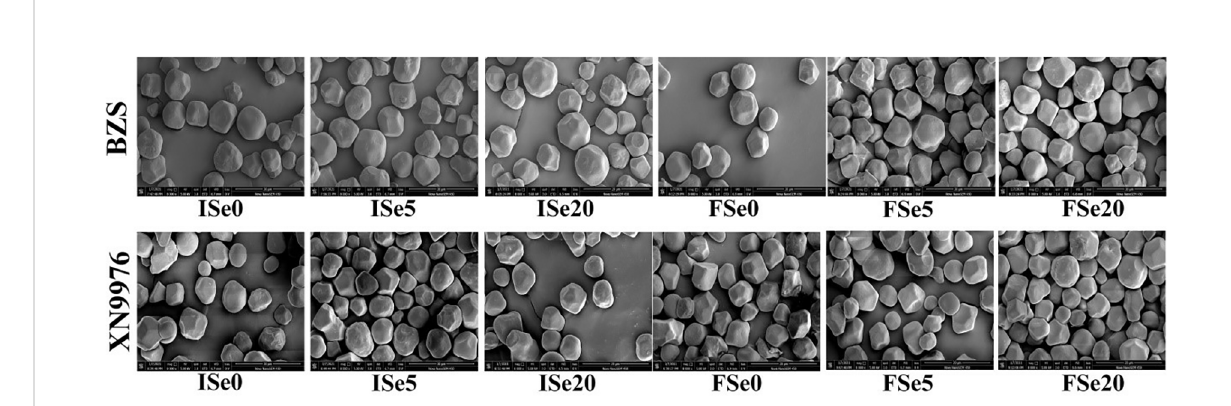
FIGURE 2 The effects of different selenium treatment levels on the morphology of common buckwheat starch